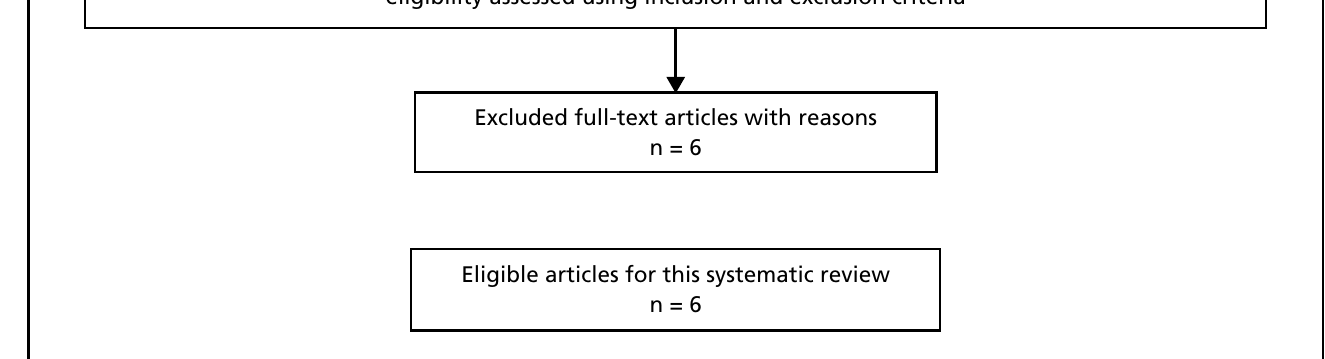
Figure 1: Results of search